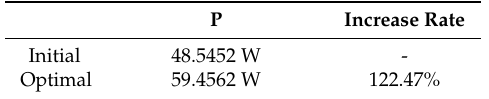
Table 7. Power amount of the initial model and optimal